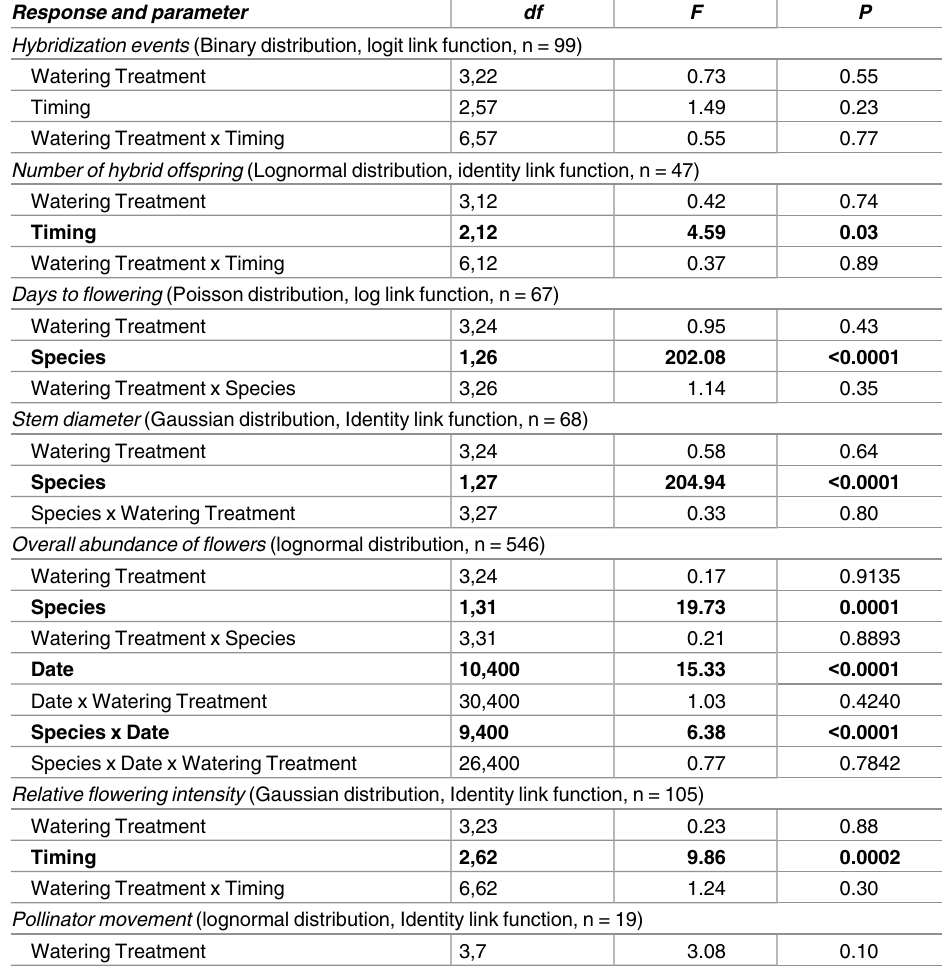
Table 1. Results from generalized linear mixed effectsmodels of the frequency of hybridization (0/1), abundance of hybrid offspring, life-history, phenology and pollinator visitation patterns in wild and crop radish (Species) grown under four watering treatments (Watering Treatment), with phenological overlap (Timing) sampled across the growing season (Date) performed using SAS PROC GLIMMIX. Response and parameter df F P Hybridization events (Binary distribution, logit link function, n = 99) Watering Treatment 3,22